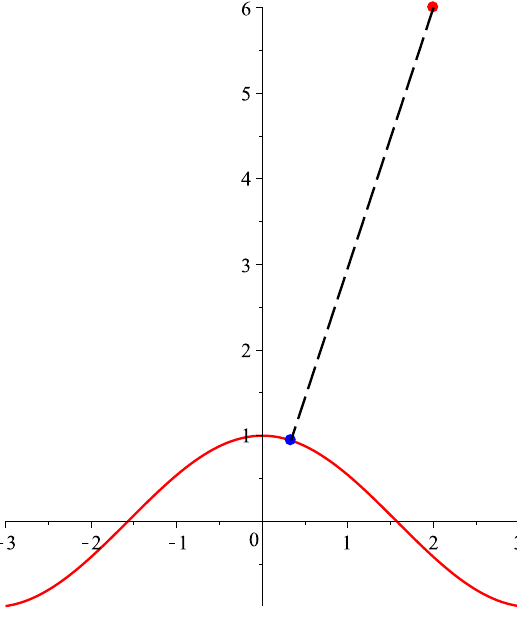
Figure 4. Geometric illustration of counterexample